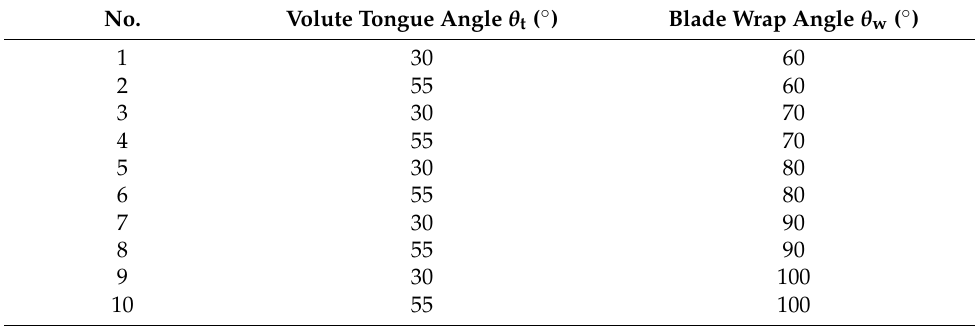
Table 2. Control factors and levels from L 10 near-orthogonal array. No. Volute Tongue Angle θ t ( ◦ ) Blade Wrap Angle θ w ( ◦